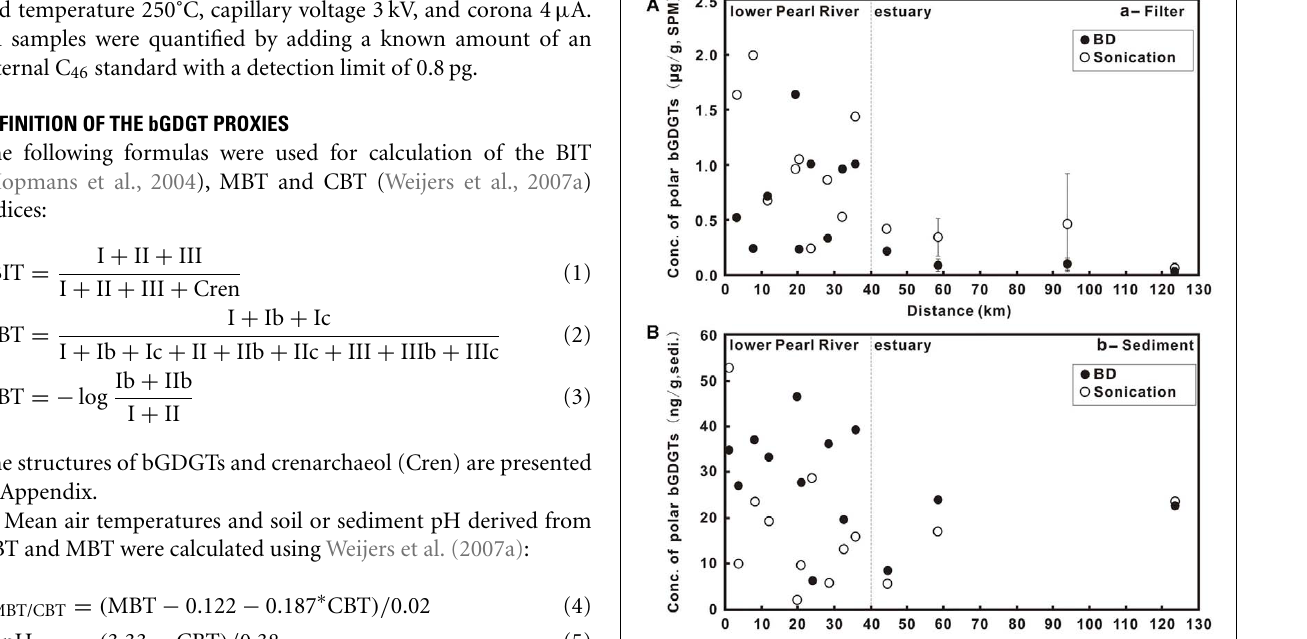
sediment (2.2 ± 0.3 μ g/g TOC) from the Bligh and Dyer method ( Figure 3D